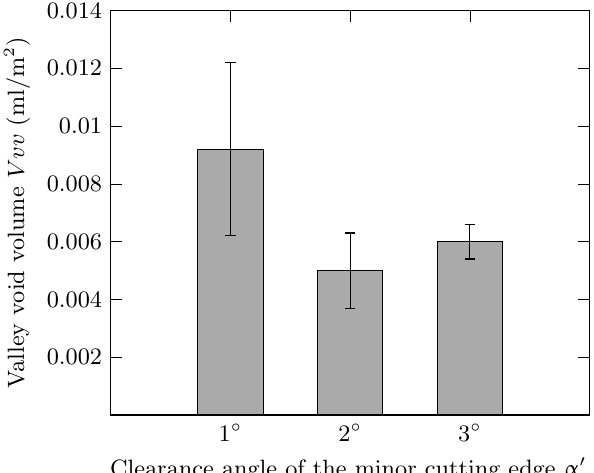
Figure 11. Valley void volume Vvv for different clearance angles α (cid:48) o of the minor cutting edge ( v c = 250m/min, f z = 0.015mm, a p = 0.25mm, a e = 0.5mm, γ (cid:48) o = 0 ◦